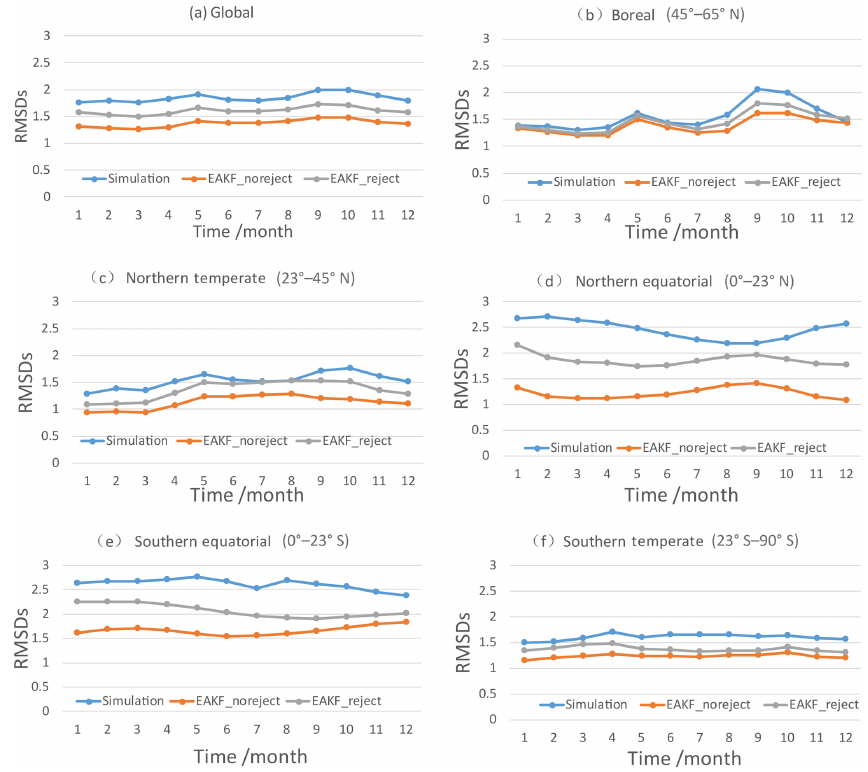
Figure 9. RMSDs of simulation experiments with and without rejection (EAKF_reject and EAKF_noreject) and GEOV2 LAI for the (a) globe, (b) boreal (45–65 ◦ N), (c) northern temperate (23–45 ◦ N), (d) northern equatorial (0–23 ◦ N), (e) southern equatorial (0–23 ◦ S), and (f) southern temperate (23–90 ◦ S)